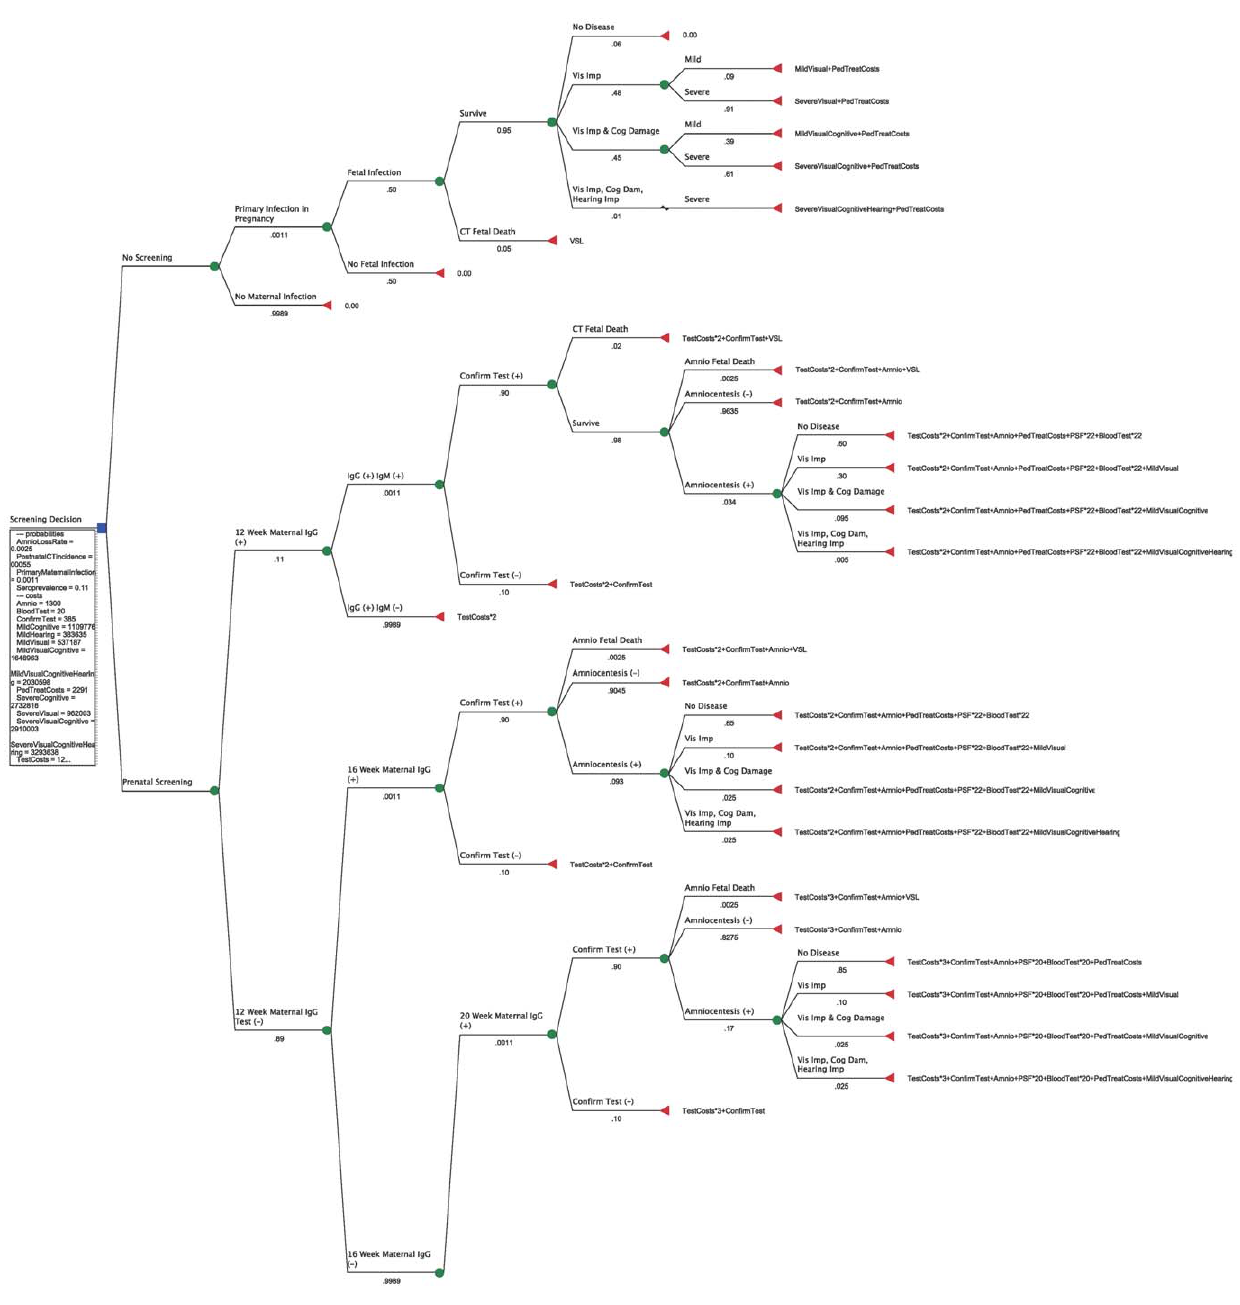
Figure 1. Decision tree with formulae (top).